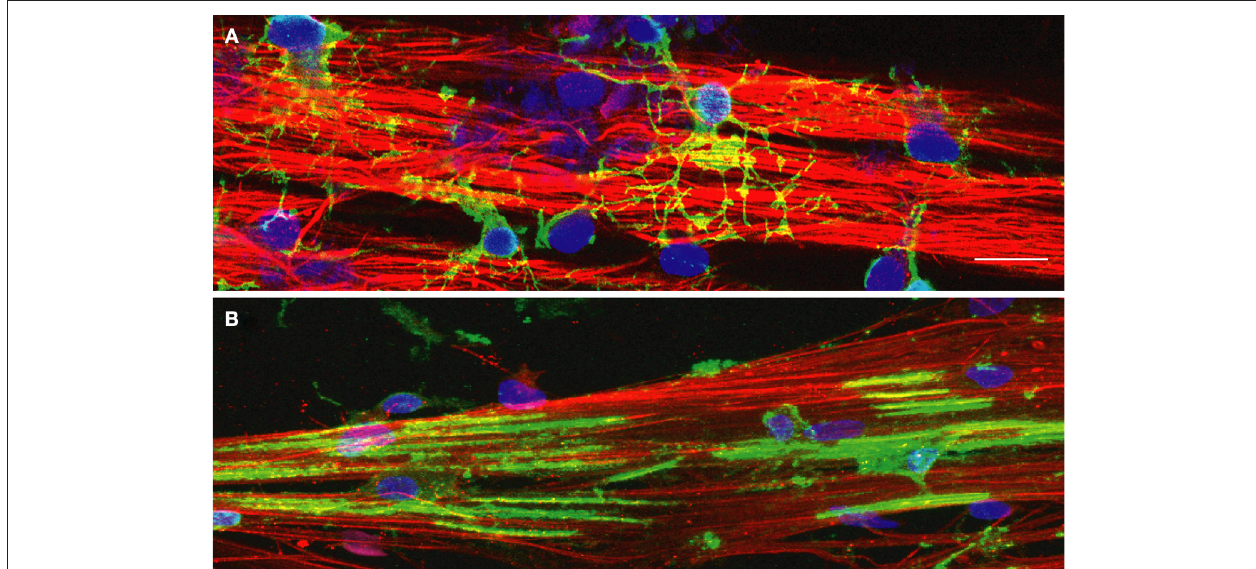
FIGURE 2 | NG2 + cells and MBP ++ oligodendrocytes grown on DRG axons in culture. DRG axons grown in culture for 3 weeks were immunostained for neurofi lament (red) to identify axons and DAPI (blue) to label cell nuclei. (A) Immature oligodendrocyte progenitor cells (OPCs) were plated onto DRG axons and immunostained for the immature OPC marker NG2 (green) after 2 days in co-culture. NG2 + positive OPCs have differentiated into multipolar